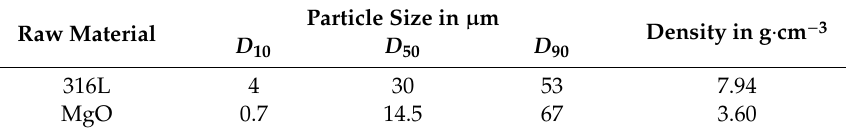
Table 2. Particle sizes and densities of the raw materials.